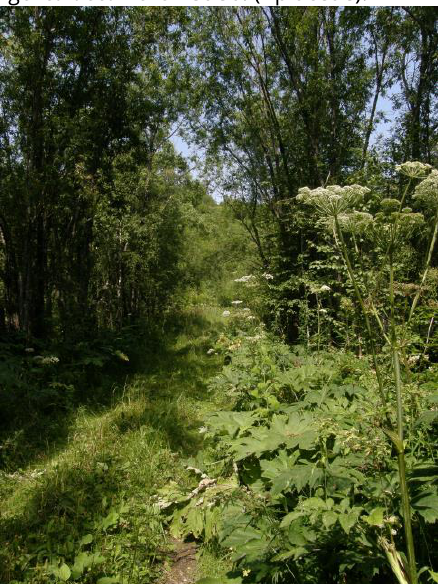
Fig. 1. Apatura iris iris (Linnaeus, 1758), female, Russia, Fig. 2. Habitat of Apatura iris iris (Linnaeus, 1758), Russia, Republic of Khakassia, Askiz District, Biskamzha River Valley, 29.07.2017 (foto: S. V.